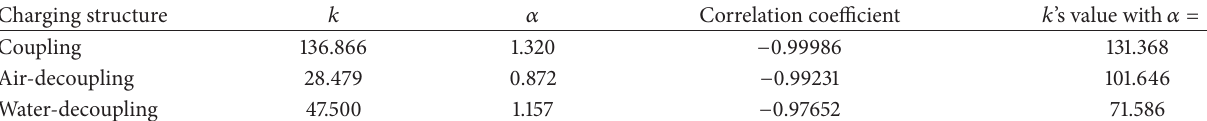
Table 2: Value of 𝑘 and 𝛼 in fitting vibration formula of different charging structures.